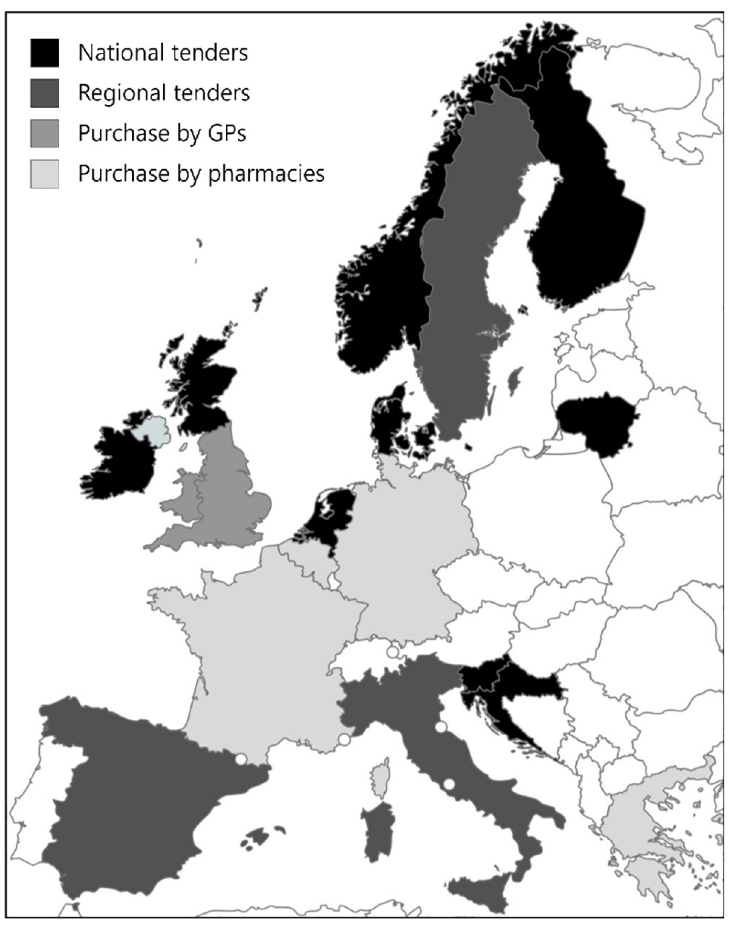
Fig 1. Four main procurement systems for seasonal influenza vaccines in 18 European countries. Republished from mapchart.net under a CC BY license, with permission from Minas Giannekas, original copyright 2021.